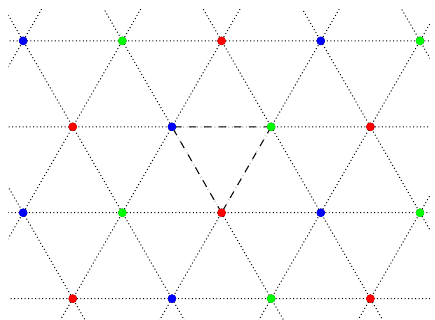
Figure 5: The triangular lattice. Qubits are placed on the vertices, which are colored in red green and blue. The (cid:90) 3 symmetry is generated by spin flips on each of the 2 individual colors (which we label, the A,B,C sublattices). The pivot is a alternate sum of a three-body Ising interaction ZZZ over all